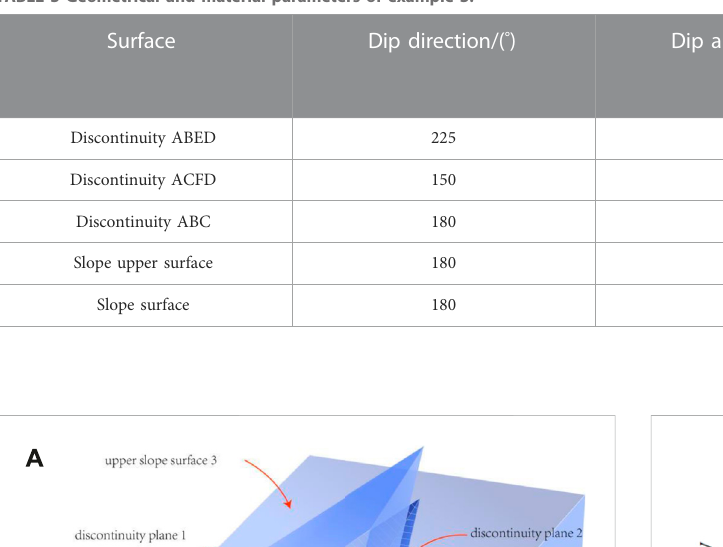
TABLE 3 Geometrical and material parameters of example 3.